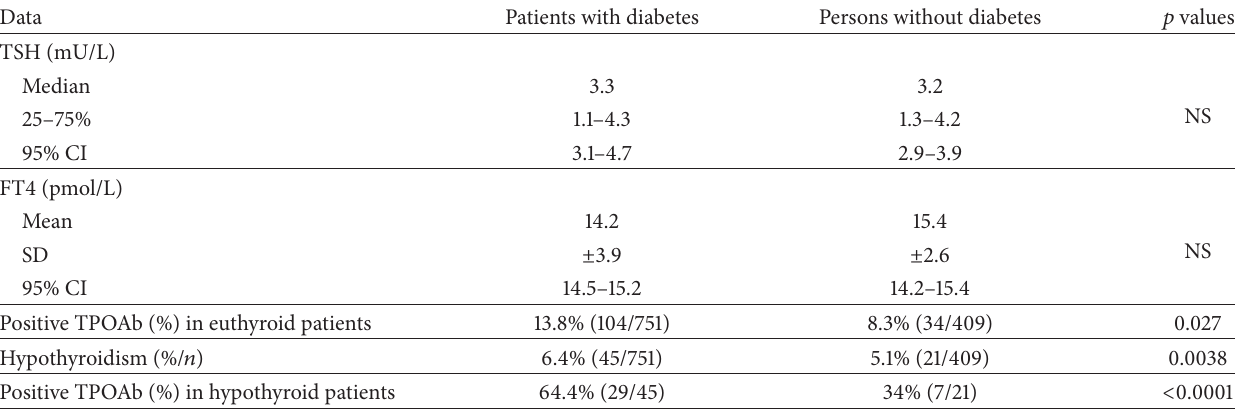
Table 2: Laboratory data in euthyroid patients and occurrence of hypothyroidism and autoimmunity in hypothyroid patients with diabetes and persons without diabetes.